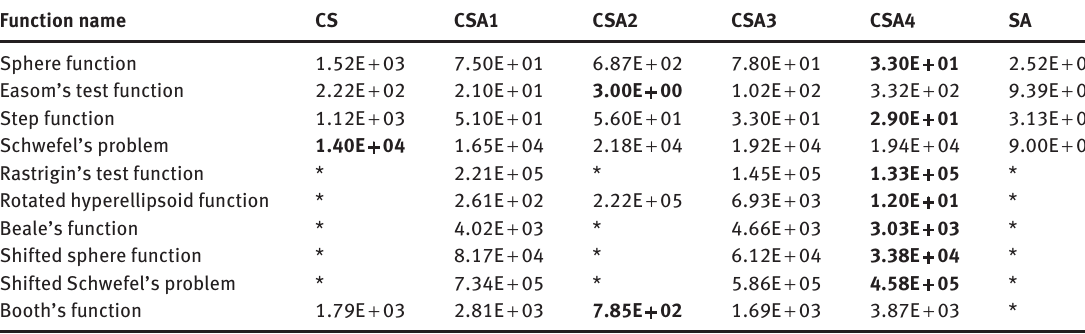
Table 8: Comparison of the Running Time of all the Variations of CSA to the Running Time of CS and SA based on the Convergence to the Best Value of CSA4.